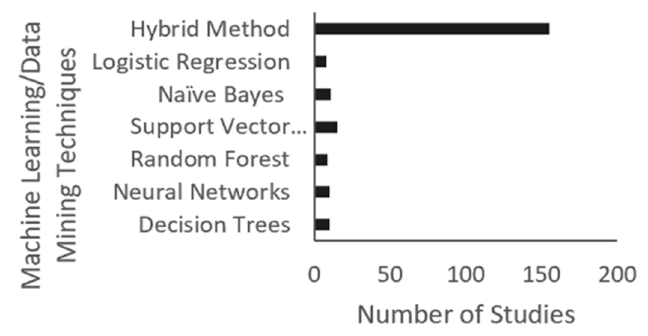
Figure 3. Machine Learning (ML) techniques used in defensive approaches.